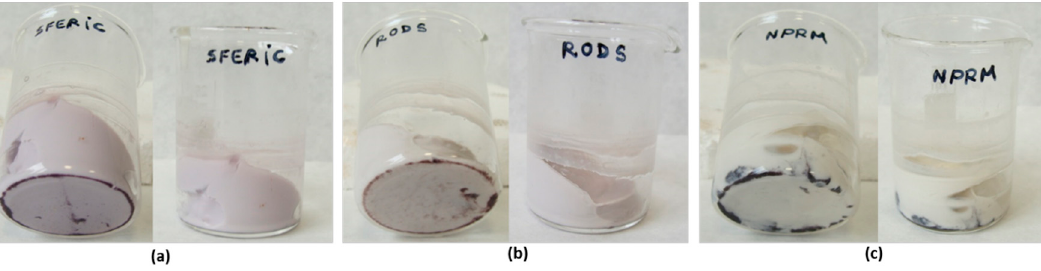
Figure 4. Photographs of YogAur obtained by AuNSs–ferment ( a ), AuNRs–ferment ( b ), and AuNPRs–ferment ( c ).